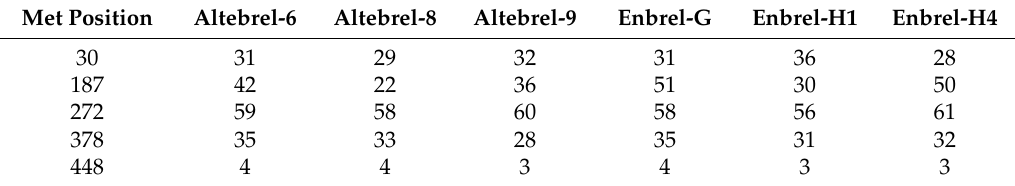
Figure 2. TICs from the originator ( A ) and the proposed biosimilar ( B ) after tryptic digestion. The main differences between the TICs are pointed out with the black arrows. The extracted ion chromatograms (XICs) for the (276)TPEVTCVVVDVSHEDPEVK(294) peptide in Enbrel-G and Altebrel-8 for the non-modified ( C ) and amidated ( D ) peptide at glutamic acid 292 can be observed. The amidated peptide is eluted at a different time compared to its non-modified counterpart. Table 1. Oxidation levels at various methionine sites in percentage.